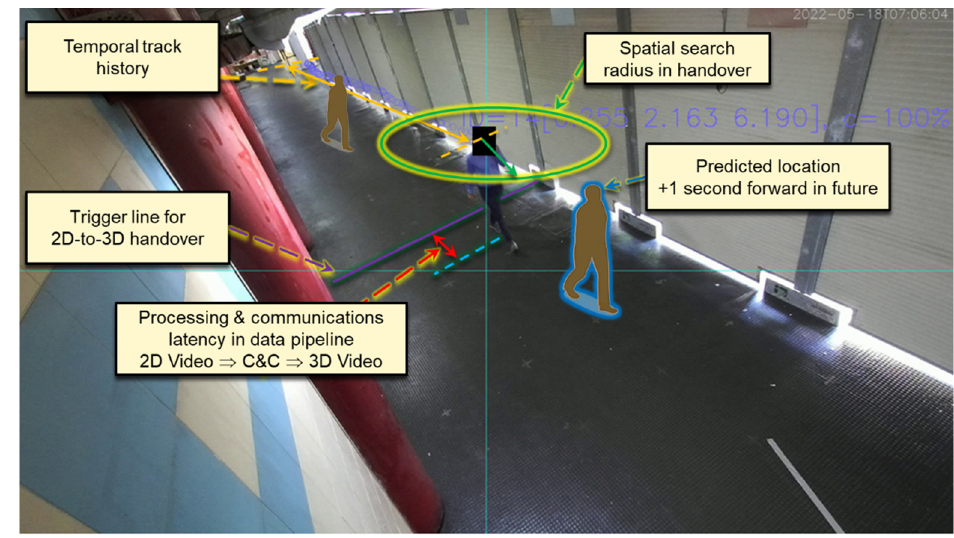
Figure 5. 2D ‐ to ‐ 3D Video system handover. Figure 5. 2D-to-3D Video system handover.